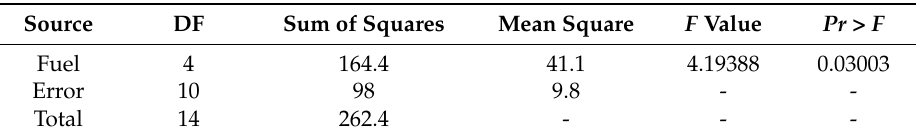
Figure 4. Effect of increasing diethyl ether percentage on blended B30 fuel heating value. Table 5. ANOVA for the heating value. Source